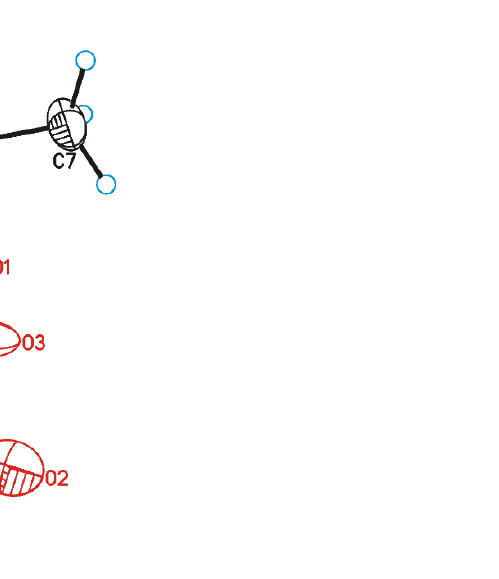
Figure 3. General view of Me compounds 10a showing atomic numbering. Thermal ellipsoids are given at 50% probability level. The first symmetrically independent molecule is shown.